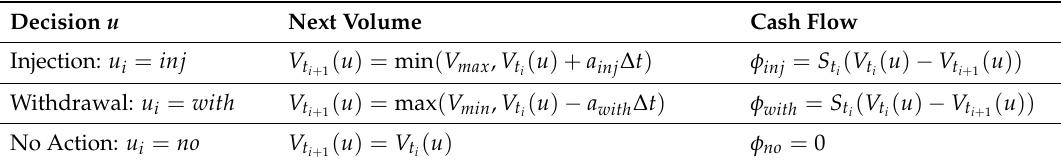
Table 1. Possible